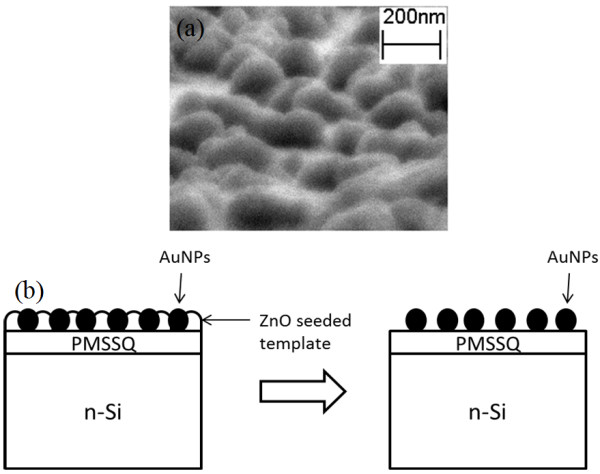
SEM image and schematic diagram. (a) SEM image of Au nanoparticles grown using the ZnO template. (b) Schematic diagram of Au nanoparticle formation between the ZnO seed layer and the ZnO-seeded template dissolution in the acidic hydrothermal reactive solution.